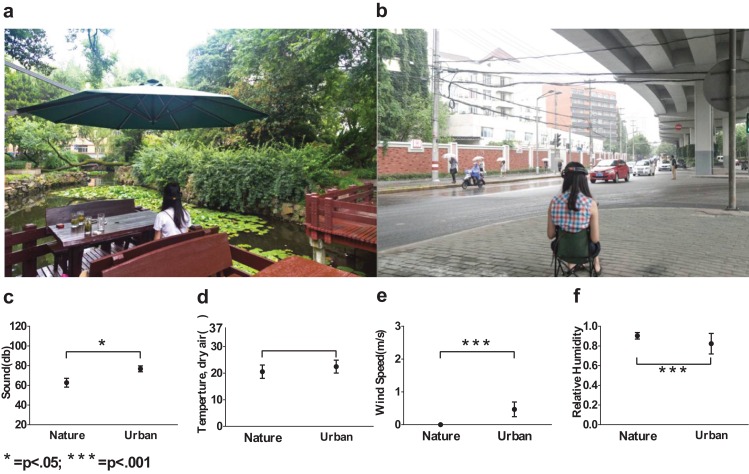
Environmental conditions used in the experiment.A shaded traffic island was used as an urban site (A) and a campus garden was used as a nature site (B), acoustic conditions (C), temperatures (D), wind speed (E) and relative humidity (F) were intentionally documented and controlled. Error bars denote SD.